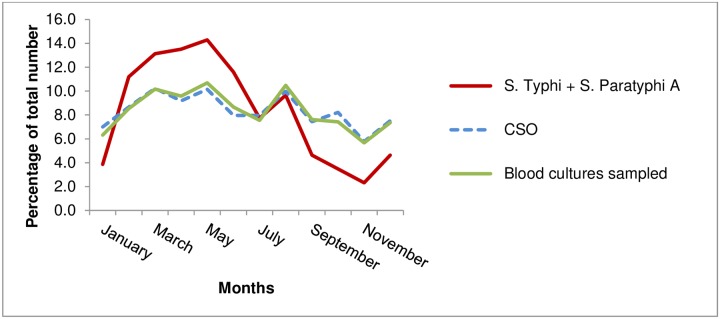
Cumulative monthly percentages of total number of blood culture bottles sampled, clinically significant organisms (CSO) and Salmonella Paratyphi A and Salmonella Typhi isolated from blood cultures at the Sihanouk Hospital Center of HOPE, Phnom Penh, Cambodia.